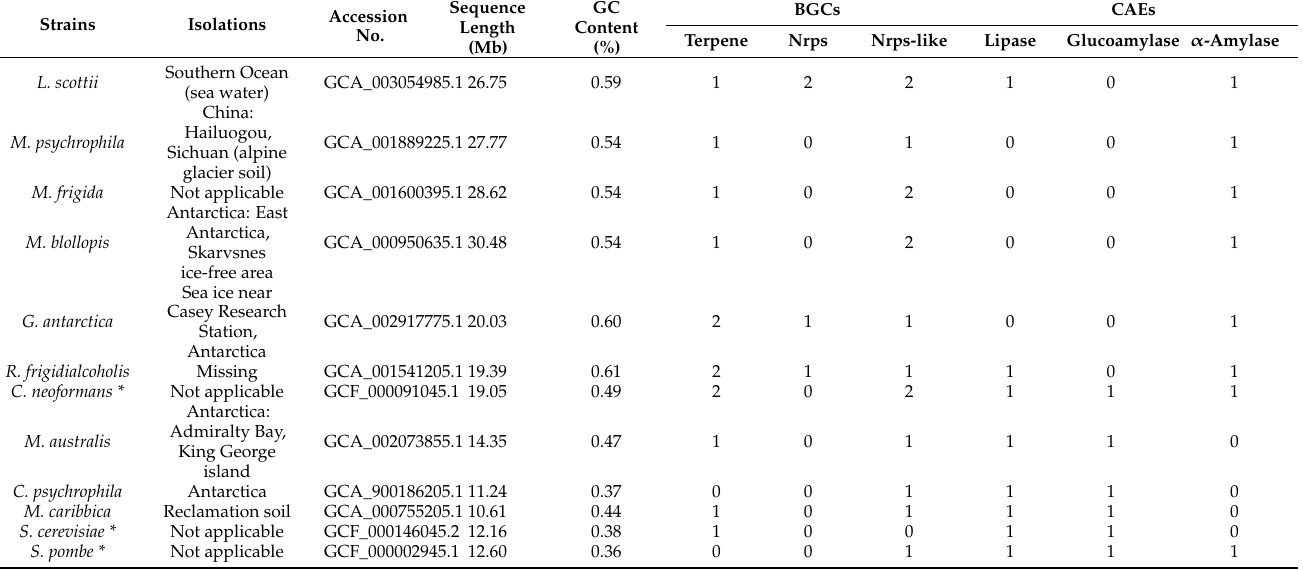
Table 1. Genomic information of different